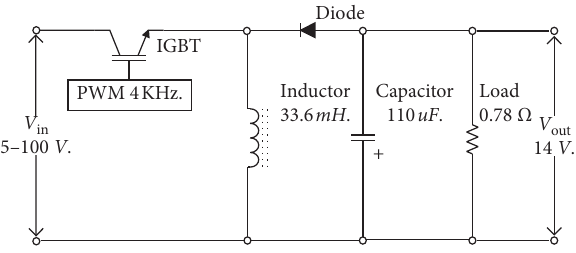
Figure 4: Designed circuit of buck-boost converter.